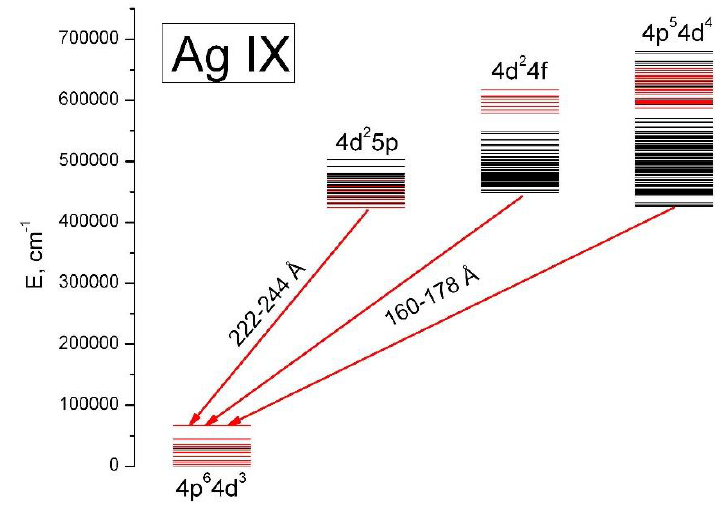
Figure 4. Energy levels of Ag IX. The arrows show electric dipole transitions studied in this article. The levels found in this work are marked by red color. Black color indicates calculated positions of unknown levels.